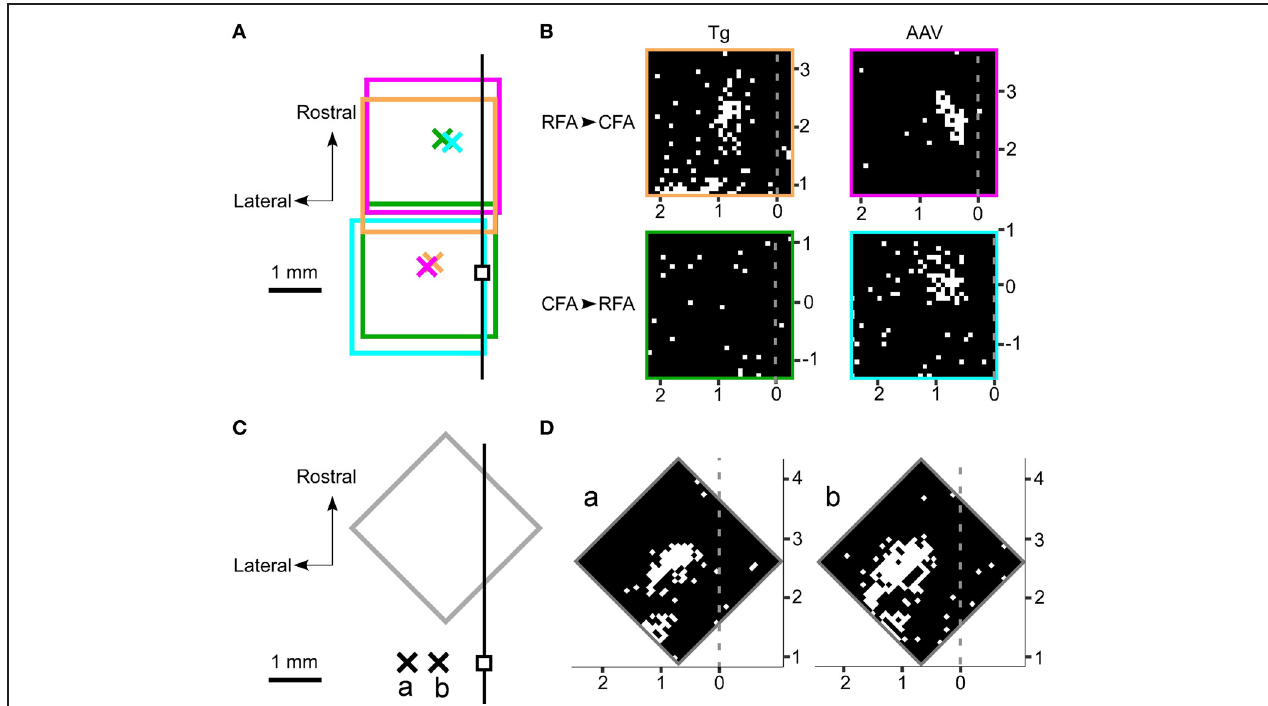
FIGURE 4 | Photostimulation mapping of functional connections between the RFA and the CFA. (A) The four rectangles represent the regions mapped by photostimulation. In each region, 32 × 32 points were pseudo-randomly stimulated with a blue laser. The laser intensity was 2.5mW and the illumination duration was 10ms. The crosses represent the recording sites. Each color represents one set of recording and photostimulation. The small black square denotes the bregma. The black line represents the midline. (B) The laser was used to stimulate 32 × 32 points that are indicated as pixels throughout the RFA and the CFA. White pixels indicate points where photostimulation induced spiking activities and black pixels reflect areas that did not induce spiking activities. The gray dotted lines represent the midline. The mapping was performed in four different mice. The top panels indicate photostimuli that were presented to